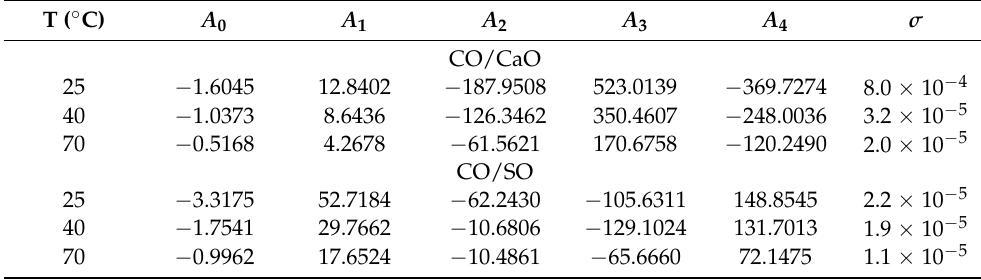
Table A2. Coefficients A i and standard deviation ( σ ) obtained from the Redlich–Kyster adjustment for the excess molar volume ( V E ) property of the binary oil mixtures.